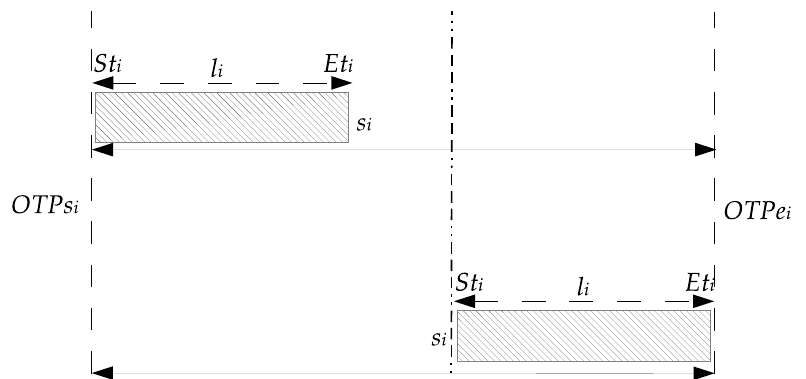
Figure 1. Time parameters